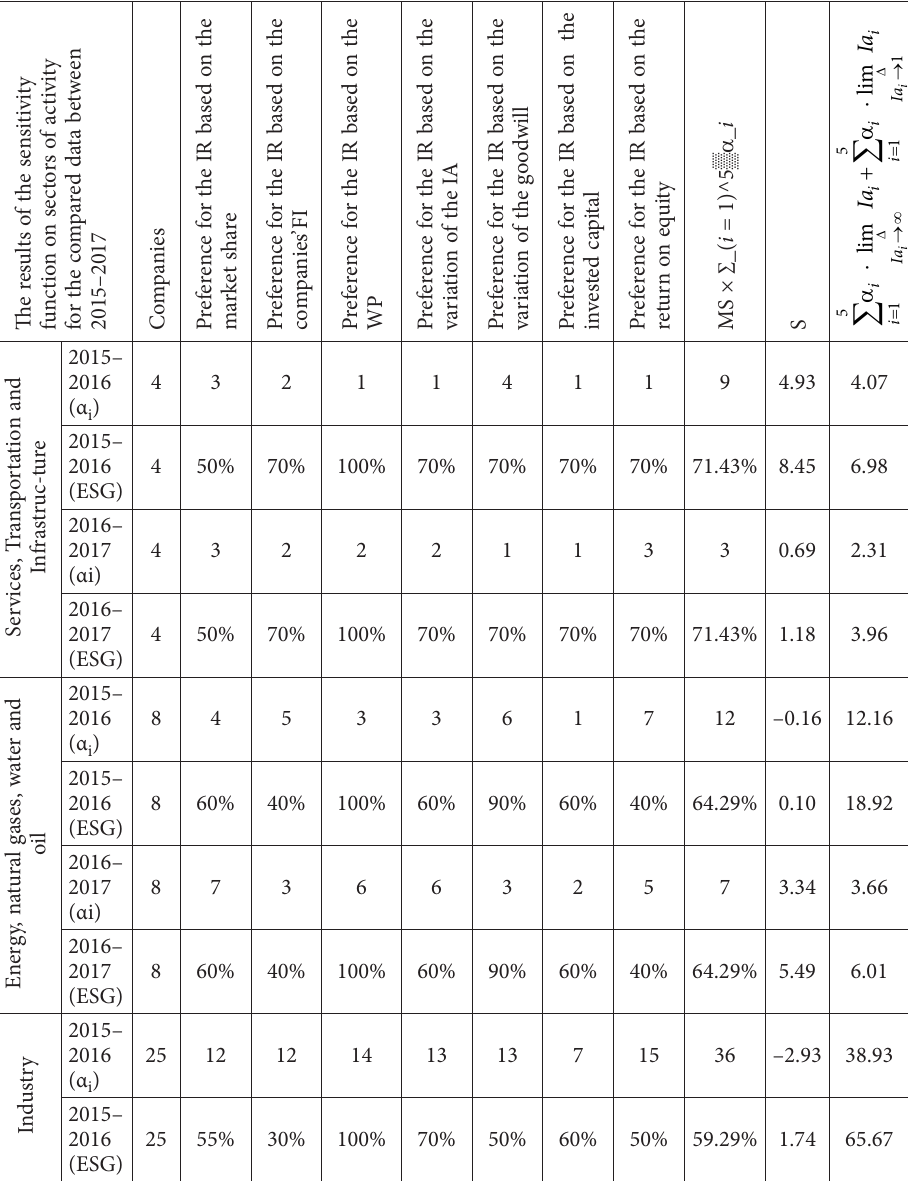
Table 1. The monitoring of the sensitivity of the preference for the IR for the companies, which were analysed from the point of view of the sectors of activity (source: author’s own